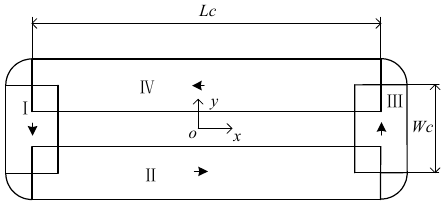
Figure 7. Simplified coil model.